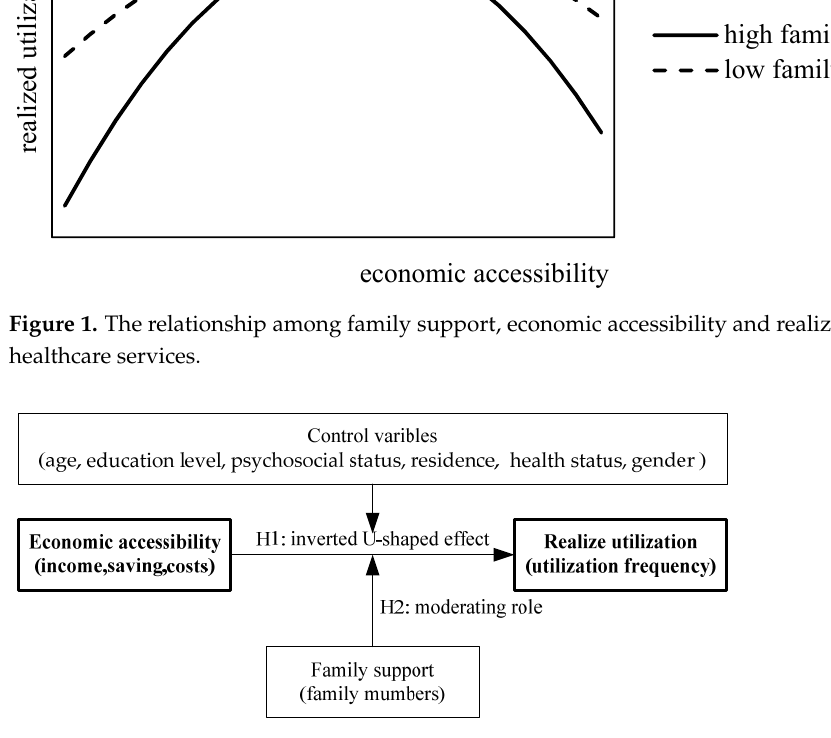
Figure 2. The conceptual framework and